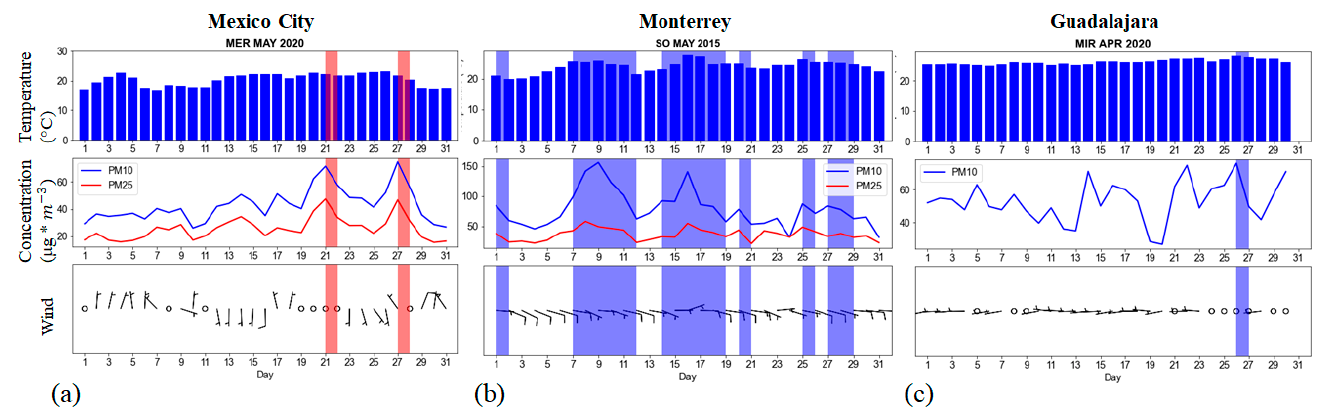
Figure 5. Representative meteograms showing the relations between wind speed and PM at stations in ( a ) Mexico City, ( b ) Monterrey, and ( c ) Guadalajara. Red bars show days that the PM 2.5 limit was exceeded, and blue bars show exceedance of the PM 10 limit. In the figure, PM 10 is represented by a blue line and PM 2.5 by a red line. The wind speed and direction are shown in the bottom of each